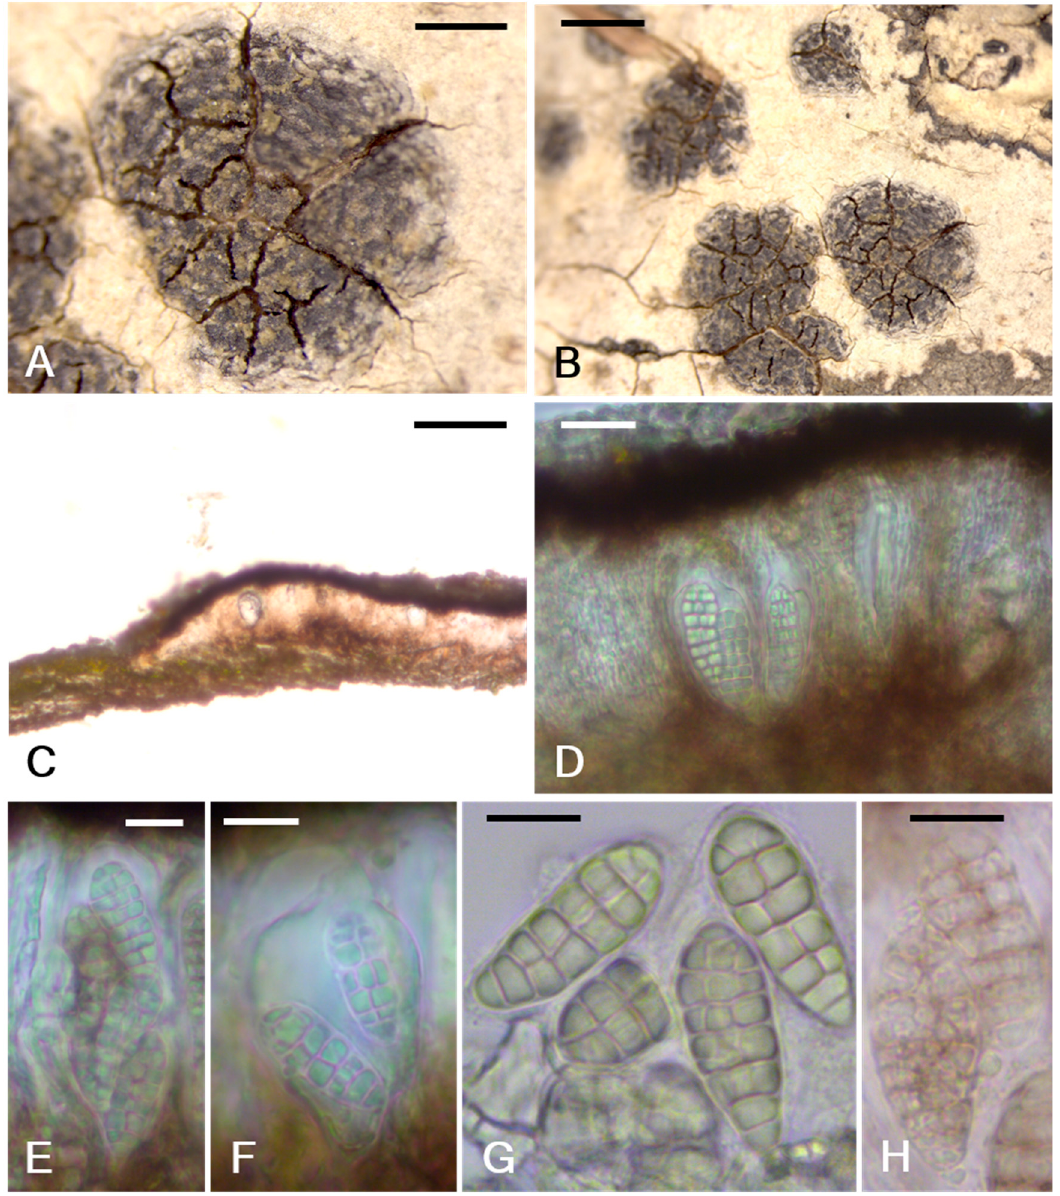
Figure 3. Arthonia ulleungdoensis . ( A , B ) Habitus with rounded and erumpent apothecia; ( C ) adnate apothecial section; ( D ) asci and ascospores in an apothecial section; ( E ) 6-spored ascus; ( F ) 2-spored ascus; ( G ) ascospores; ( H ) old ascospores with dark septa (scale bars: A = 1 mm; B = 0.5 mm, C = 100 µ m, D to F = 20 µ m, G and H = 10 µ